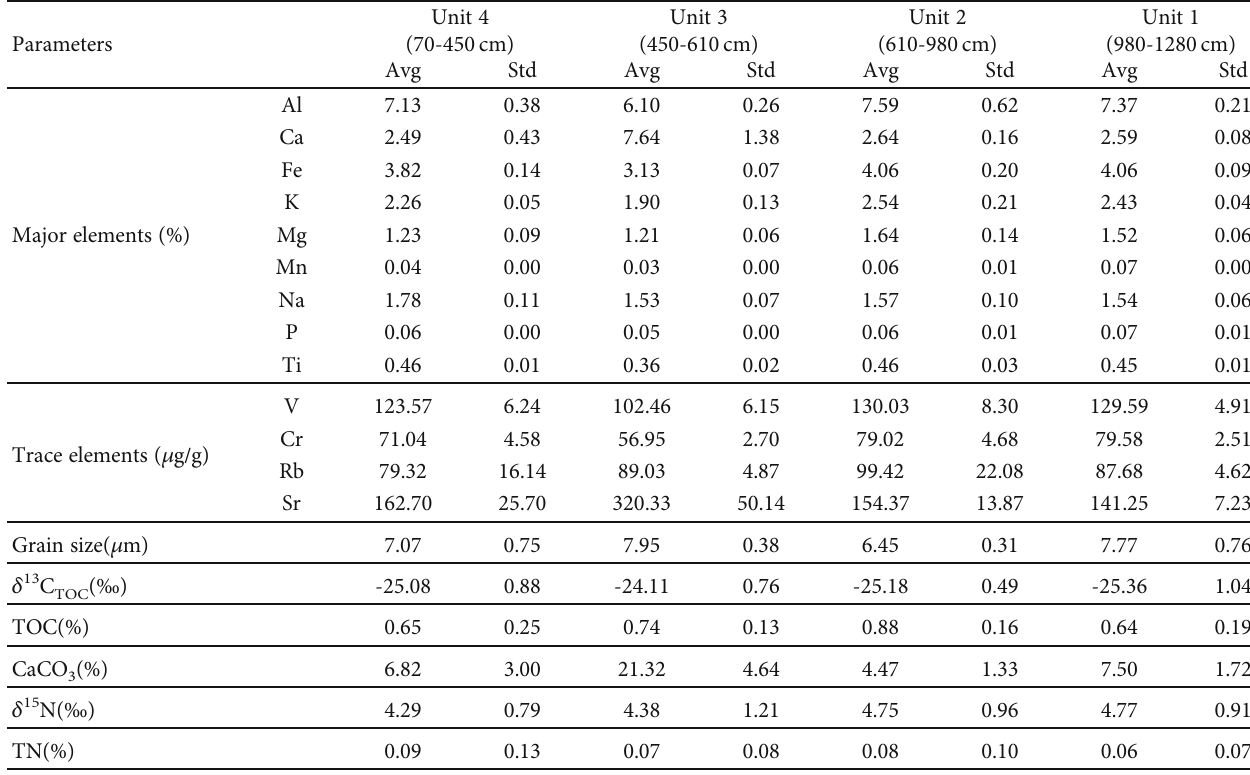
Table 1: Average (avg) and standard deviation (std) of geochemical parameters in di ff erent intervals of the core 973-4. Major elements are given in weight percent (%) while trace elements are in μ